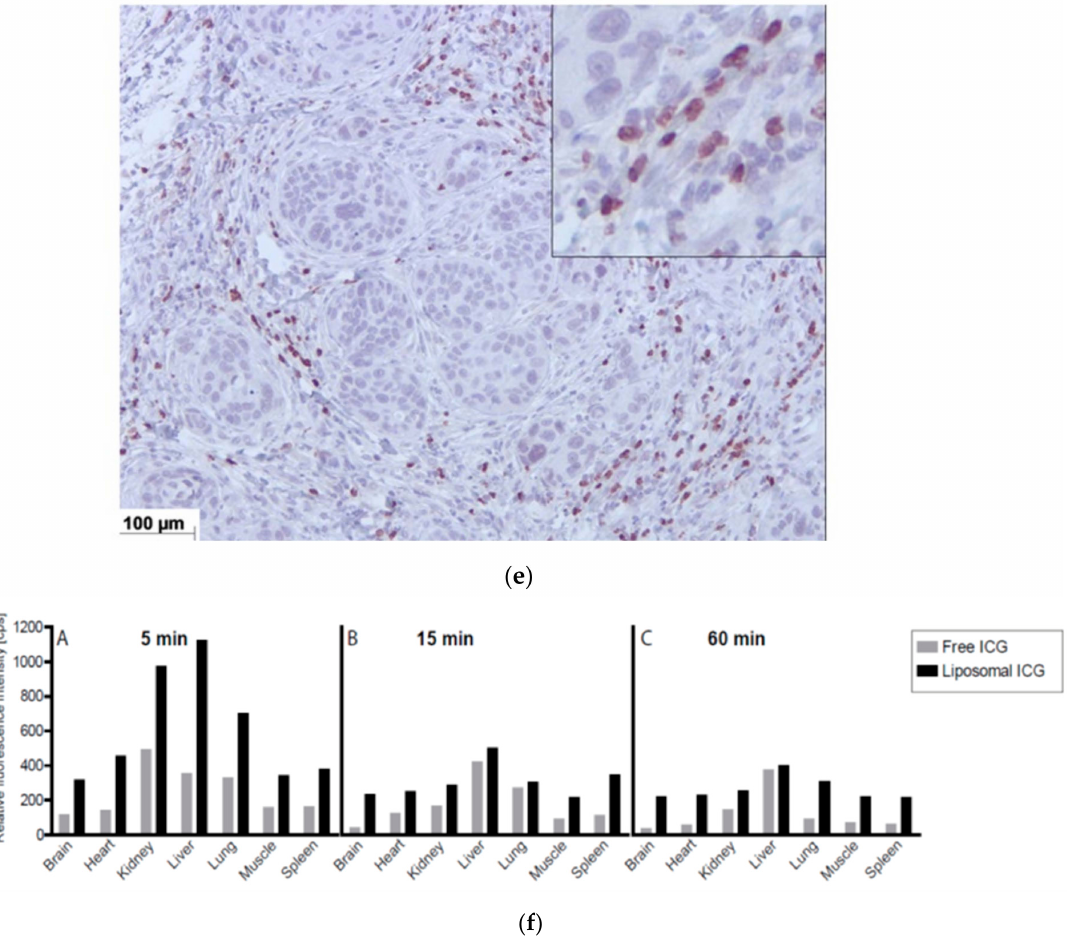
Figure 3. Characterization in vivo. ( a ) Blood clearance of the MESL liposomal particles loaded with ICG. The image shows a plot of ICG signal from the blood represented as %ID / mL, as determined by the absorbance at 800 nm at 5 ( n = 3), 15 ( n = 4), 30 ( n = 6), 60 ( n = 6), 90 ( n = 3), and 120 ( n = 4) min after intravenous injection. Each bar represents mean ± SEM. ( b ) Dynamic blood kinetics determined using photoacoustic imaging of the mouse femoral artery. RI in y-axes represents relative intensity for fluorescence. The injected amount was the same as well as c max in blood. Both nontreated SM- liposomes ( • ) (DSPC:SM:DOTAP:chol (20:30:20:30) mol / mol, loaded with Fe NPs and ICG)), as a control, and SM-liposomes pretreated with SMase (0.4 U), and AMF (5 min 2 mT, 100 kHz) ( (cid:4) ) were injected in the mouse tail vein and followed by imaging femoral artery for 15 min ( p -value 0.0001, t -test two-tailed unpaired). ( c ) Biodistribution of ICG filled MESL liposomal nanoparticles for the first 2 h after IV injection. Fluorescence images were acquired after 5 ( n = 3), 15 ( n = 4), 30 ( n = 6), 60 ( n = 6), 90 ( n = 3), and 120 ( n = 4) min. Each bar represents the mean ± SEM. ( d ) ASMase activities analyzed with Amplex Red reagent-based assay in human SCC-9 tumor xenografts in mice. Muscle tissue was analyzed as control tissue. The activity was assessed immediately after mouse decapitation and dissection and was normalized by the weight of the tissue sample. In the average columns, both bars represent mean ± SEM. ** represent t -test results smaller than 0.005. ( e ) Histological staining of ASMase from SCC tumor xenograft slices. ( f ) We compared biodistribution of the liposomal ICG to Free ICG, which shows the liposomal ICG to be in circulation for longer. This result was also observed in the blood kinetic